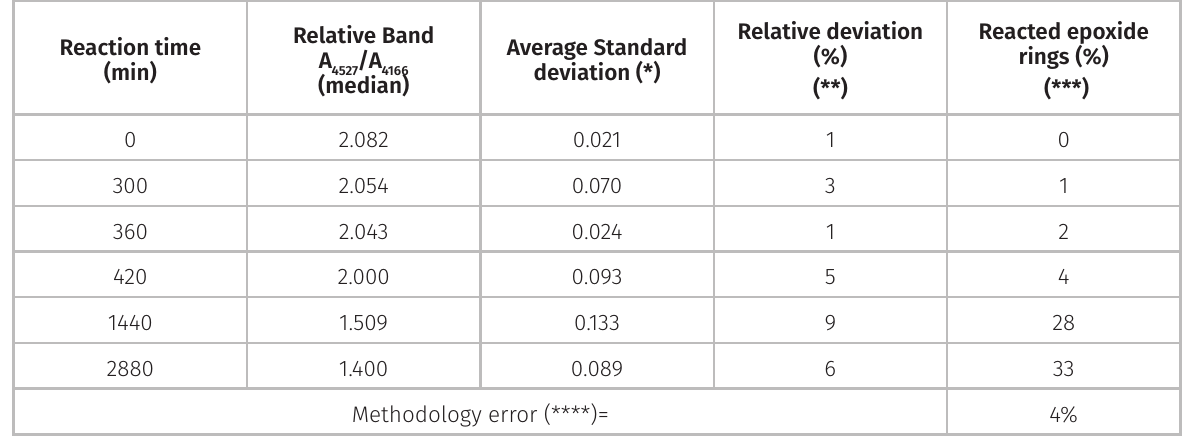
/A ) results of the EP/n-SH (1:1) system, reacted at 122 o C. 4527 4166